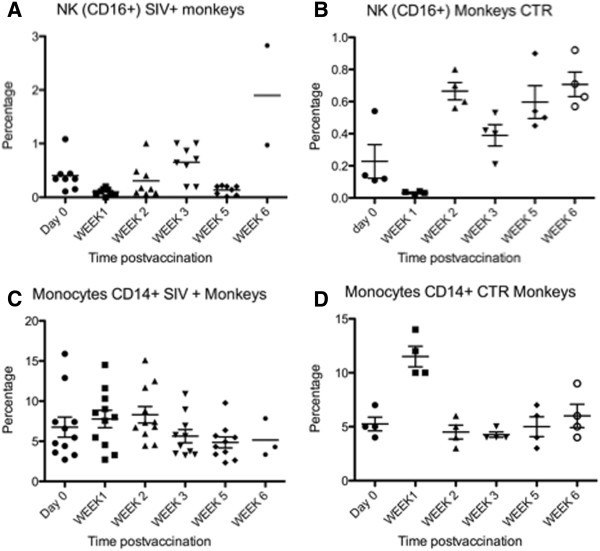
Percentage of monocytes and NK cells in PBMC after ML29 vaccination. A) In the 8 SIV-infected, ML29-vaccinated monkeys there is a significant reduction of the percentage of circulating NK (CD16+) cells one week after vaccination. B) Reduction of the NK (CD16+) population in four healthy (non-SIV-infected) animals one week after ML29 vaccination. C) In the 11 SIV-infected, arenavirus-vaccinated monkeys there is a slight increase in monocytes a week after ML29 vaccination. D) This increase is also observed in non-SIV-infected control monkeys.